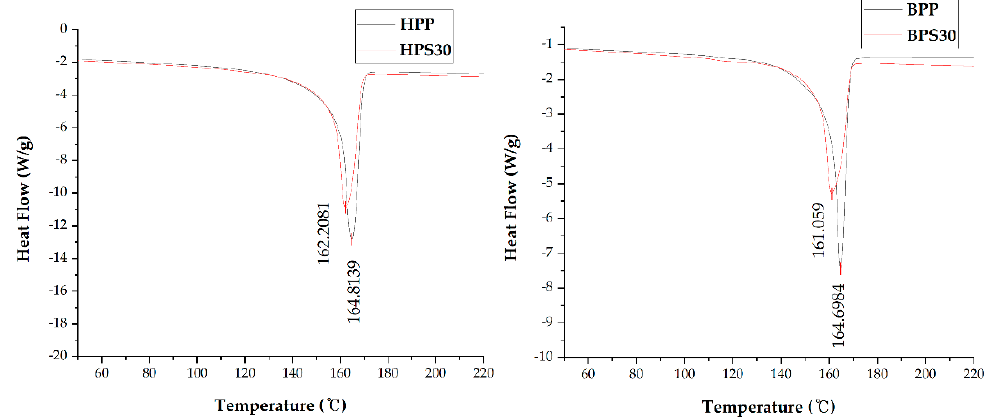
Figure 4. Cooling curve of differential scanning calorimetry (DSC) results.